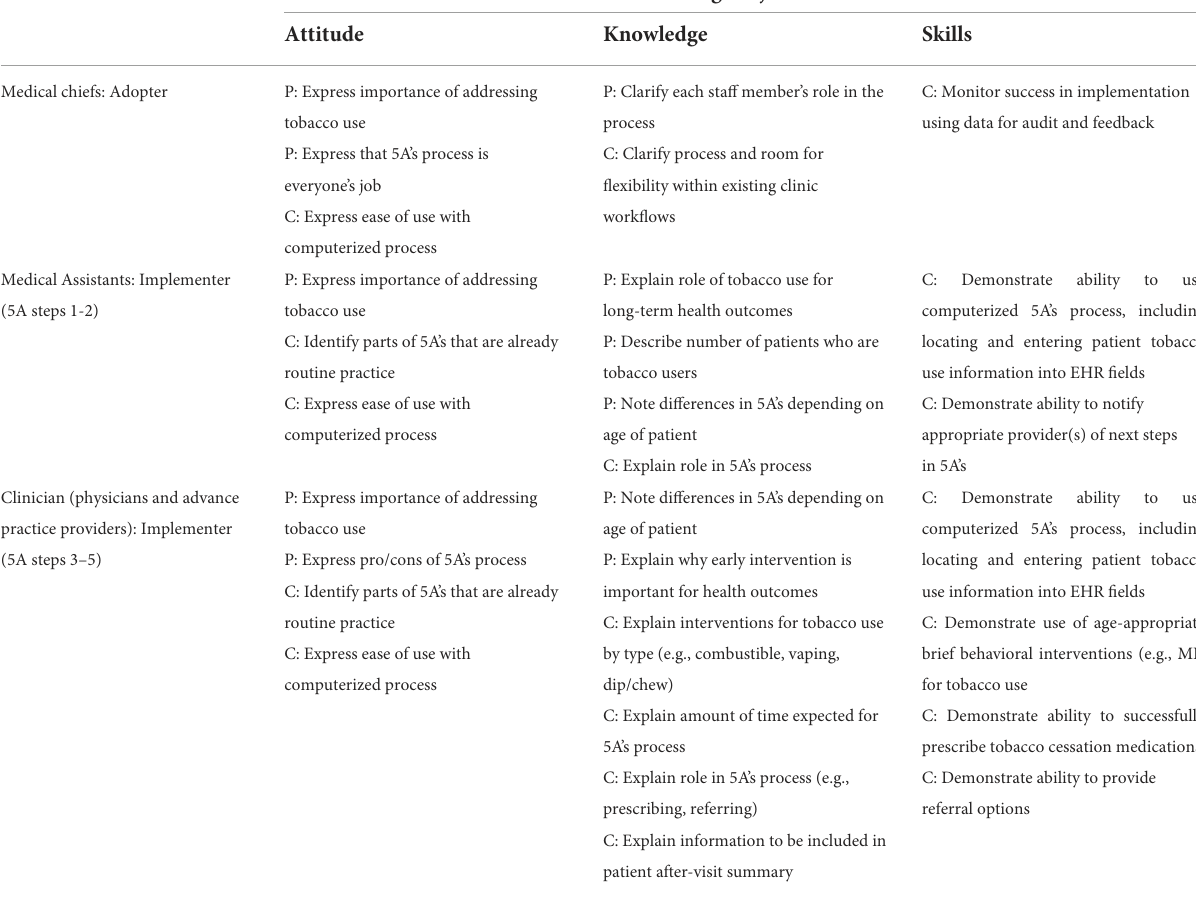
TABLE 3 Change objectives by implementation role.